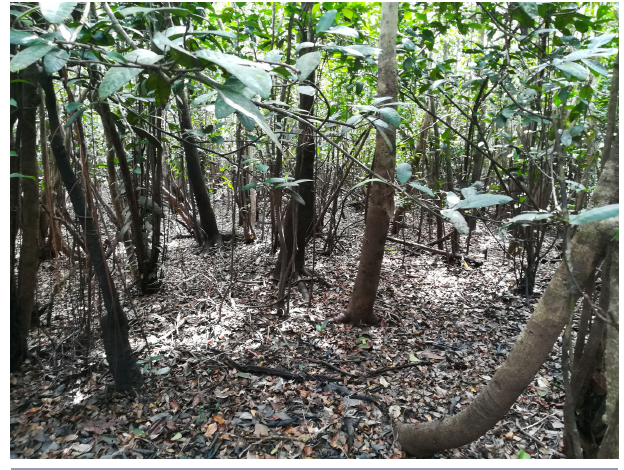
Fig. 5 . A leuuaku ; this ecosystem consists of seasonally flooded